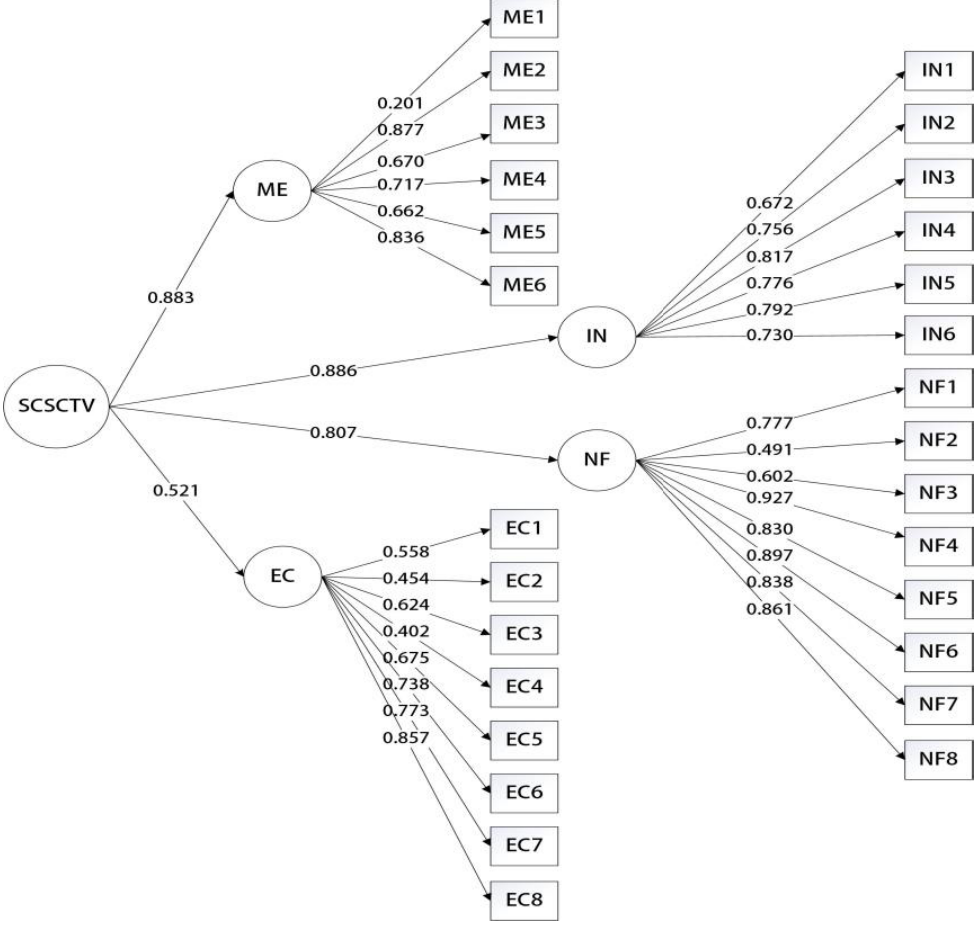
Figure 4. Factor loadings of the four‑factor SCSCTV with 28 items.